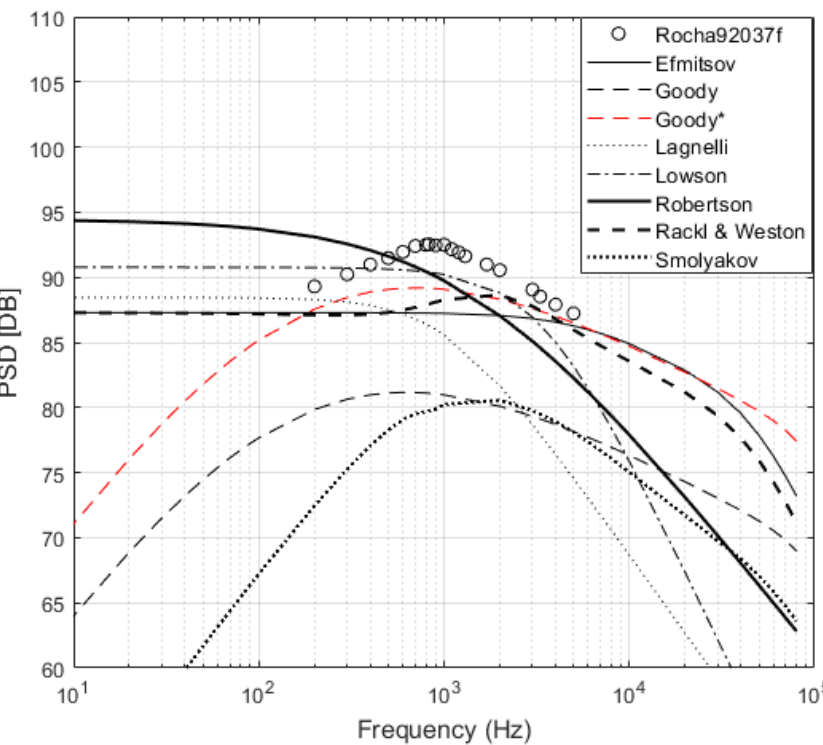
Figure 6. Rocha92037f compared to models, MSE for each model: Efimtsov 16.1, Goody 110.3, Goody* 6.4, Lagnelli 56.1, Lowson 4.1, Robertson 8.8, Rackl and Weston 11.4, Smol’yakov